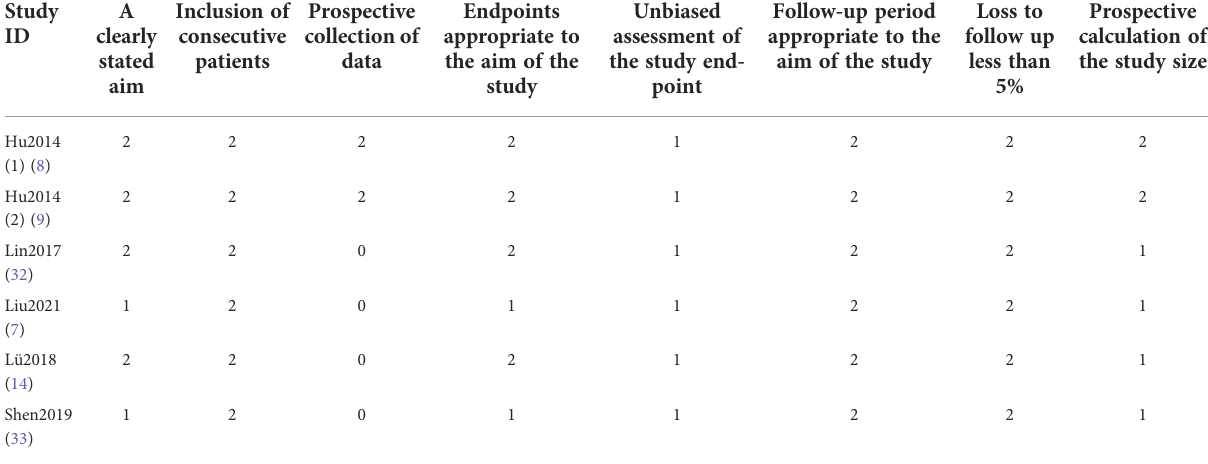
TABLE 1 Methodological quality evaluation of the included studies using methodological index for non-randomized